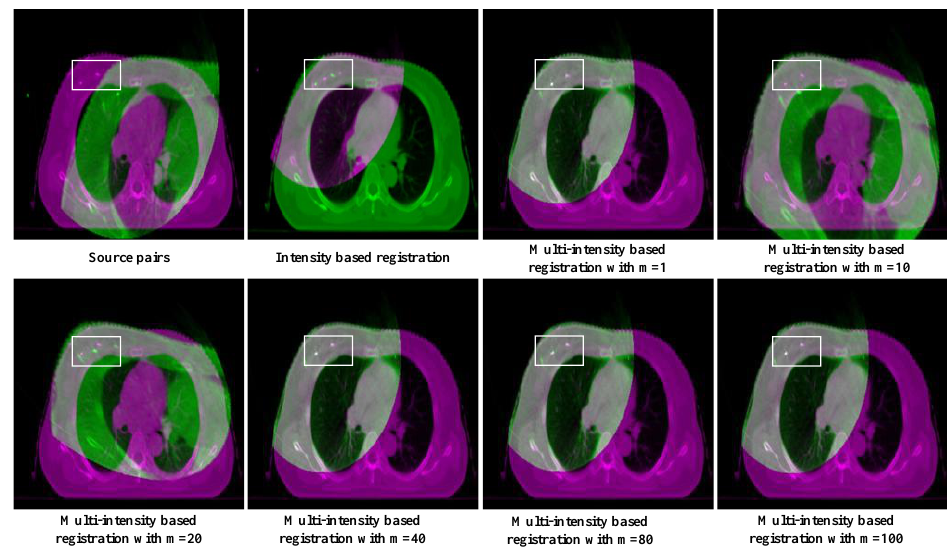
Figure 7. Multi-intensity-based registration results using different m .